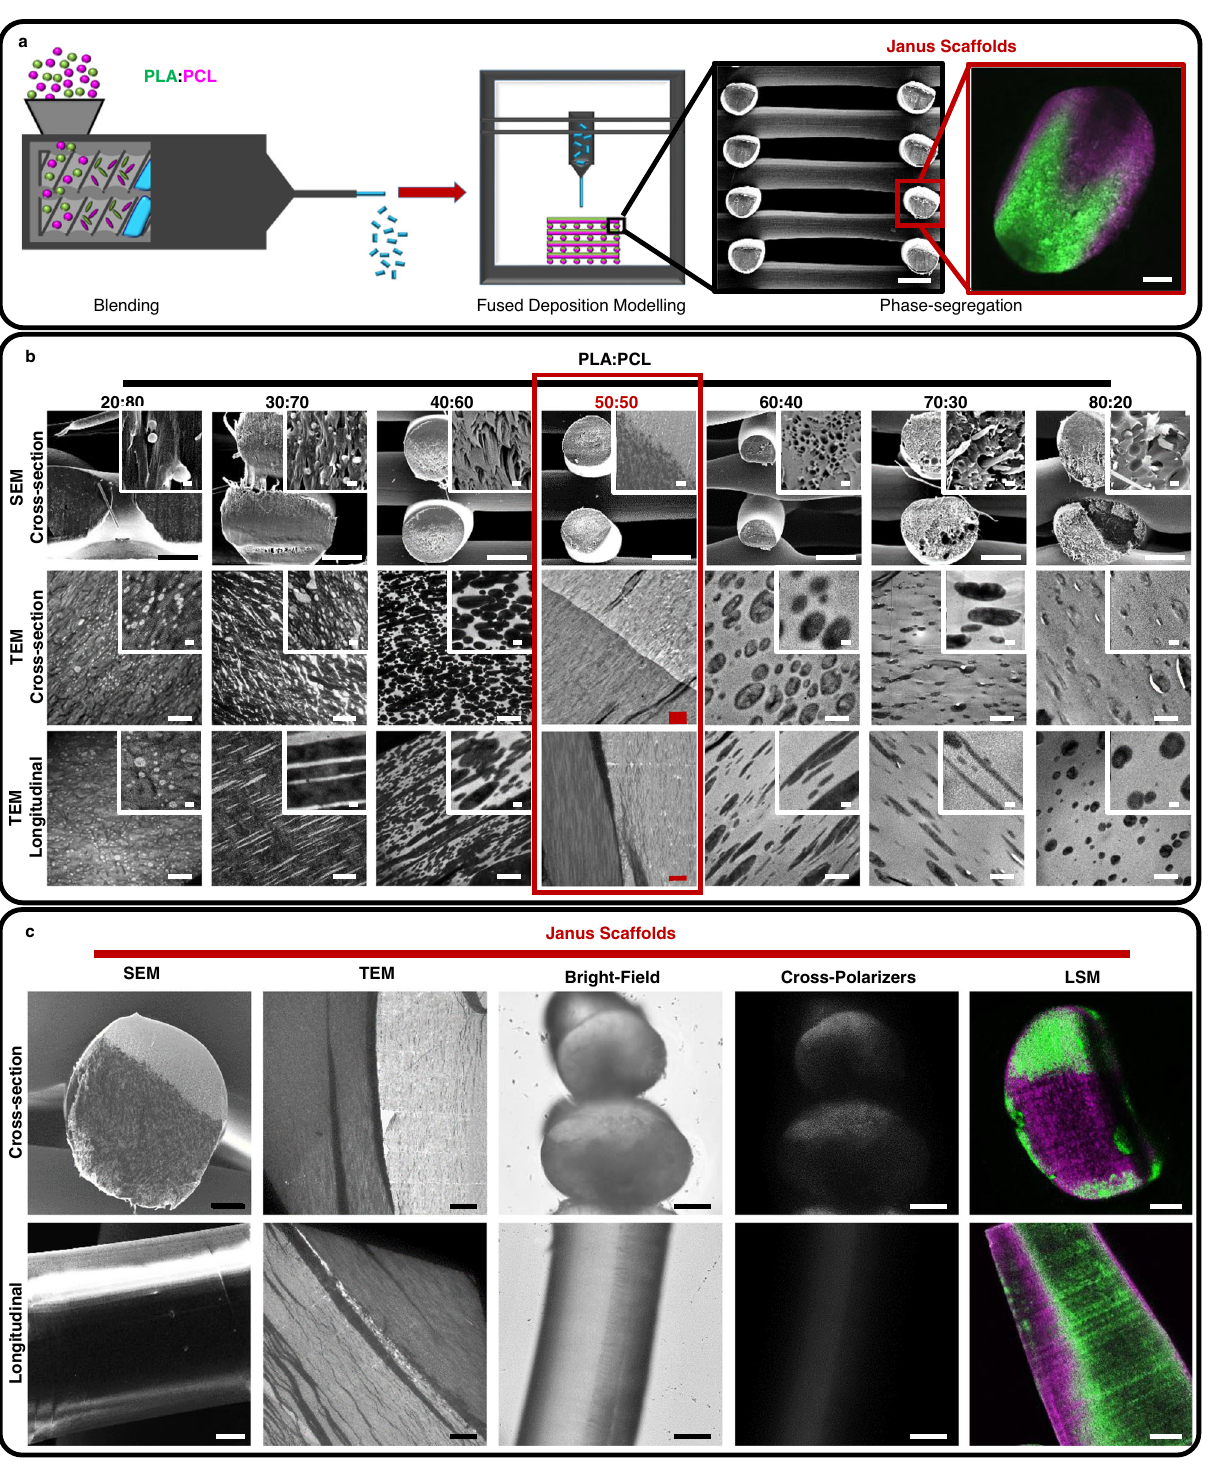
Fig. 1 PLA:PCL blends phase-segregate during FDM following nucleation, growth and spinoidal decomposition and form Janus scaffolds at a 50:50 polymer ratio. a Schematic representation of the process to create phase-segregated scaffolds. The materials were fi rst blended to obtain fi laments that were then cut in pellets to feed the 3D printer (left) where the phase segregation occurs as the material is deposited (middle) to give rise to Janus scaffolds (right). b Characterization of the phase-segregation in the cross-section of FDM scaffolds by scanning electron microscopy (SEM, scale bars are 500 and 5 µ m for the insets), and transmission electron microcopy (TEM) on the cross-sectional and longitudinal directions. PCL appears as high-contrast phases (crystalline, dark) and PLA as low contrast phases (amorphous, bright). For the TEM images, white scale bars are 5 µ m and 1 µ m on the insets; red scale bars are 10 µ m. Red box indicates Janus scaffolds. c Characterization of Janus structures in the scaffold ’ s fi ber cross-sectional and longitudinal directions by SEM, TEM, optical microscopy on bright- fi eld and under cross-polarizers, and light scanning microscopy (LSM). Scale bars are 100 µ m except on TEM images were scale bars are 10 µ